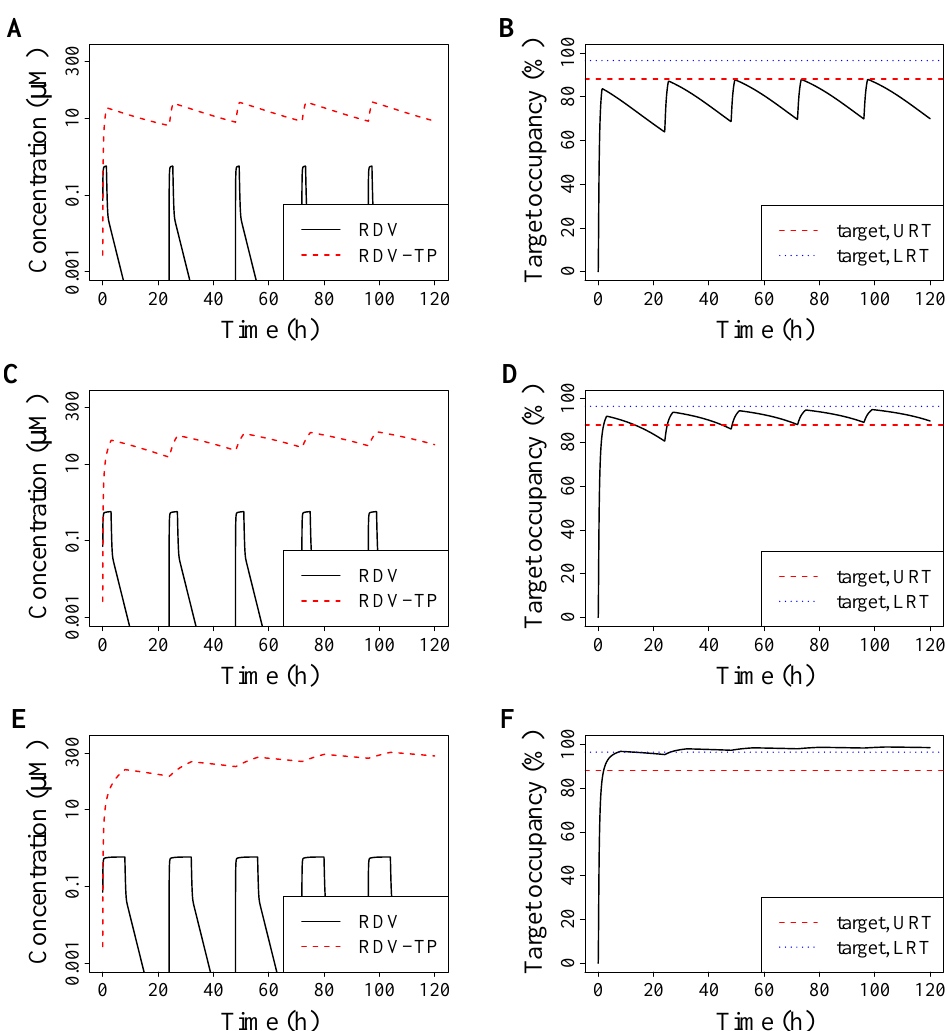
Figure 4. Pharmacokinetics and target occupancy with alternative dosing regimens. ( A , B ) 225 mg infused over 80 min. ( C , D ) 500 mg infused over 3 h. ( E , F ) 1350 mg infused over 8 h. ( A , C , E ) show the simulated pharmacokinetics. We simulate five days of treatment (time given in hours). The concentration of RDV in plasma (black line) and RDV-TP in blood cells (PBMCs, red line), is given in µ M. ( B , D , F ) show the resulting target occupancy as obtained from the intracellular RDV-TP concentration on the left hand panel and Equation (2). The red dotted line indicates the minimal effective target occupancy for the LRT and the green dotted line the same for the URT. Both were calculated with Equation